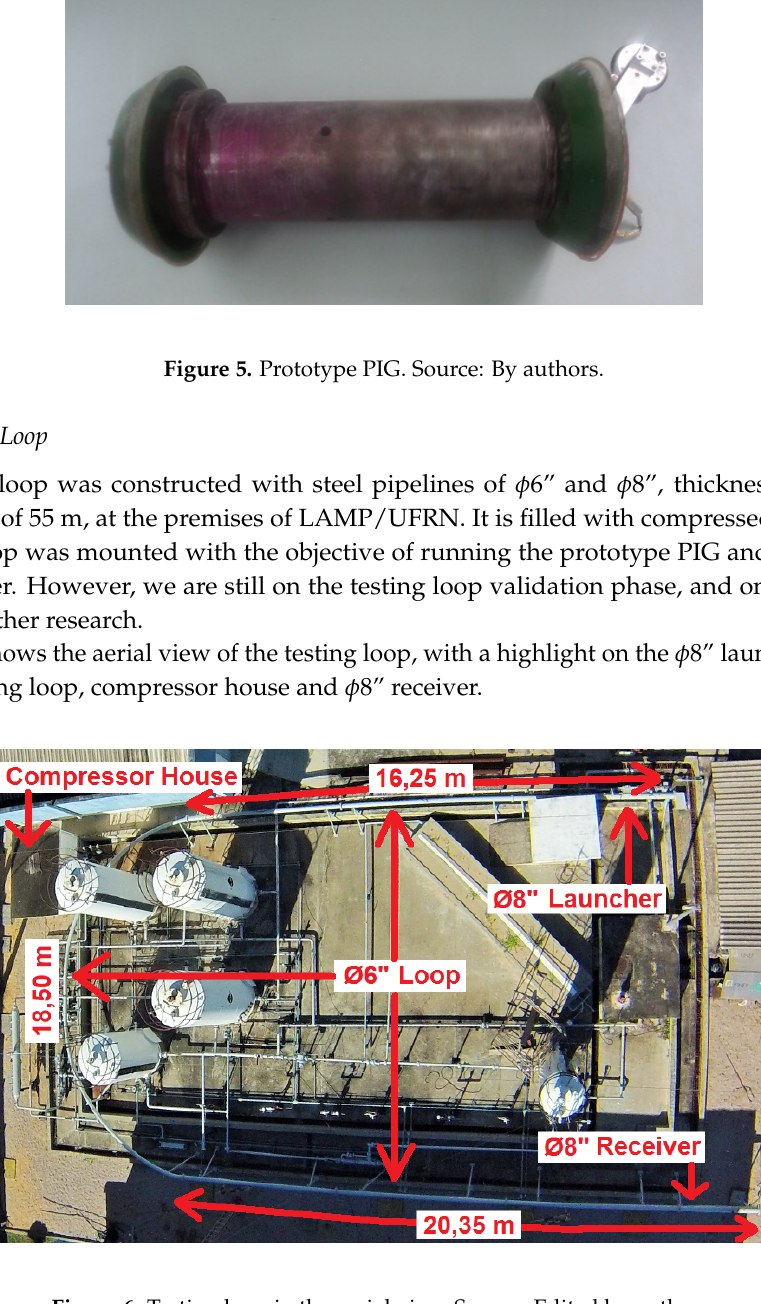
Figure 6. Testing loop in the aerial view. Source: Edited by